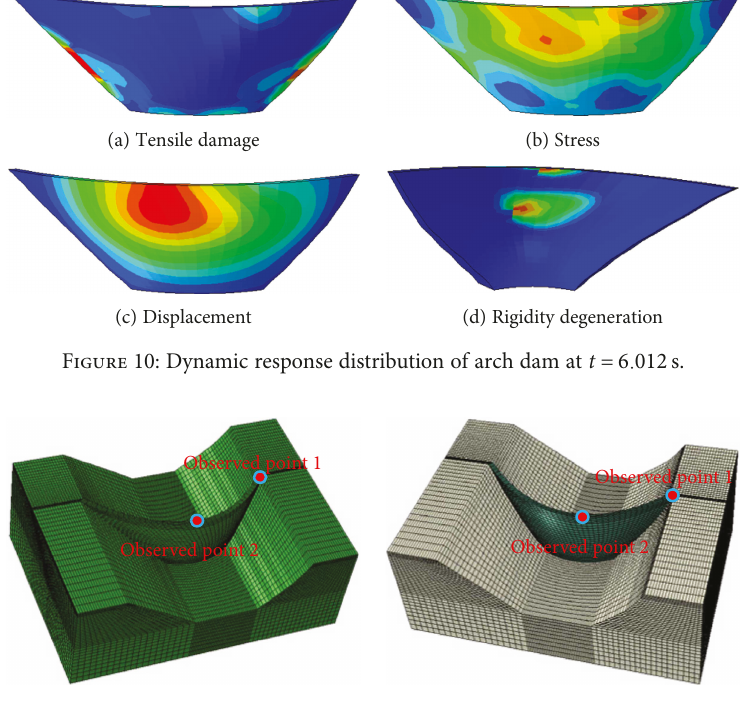
Figure 11: Observation points of time-interval responses of arch dam